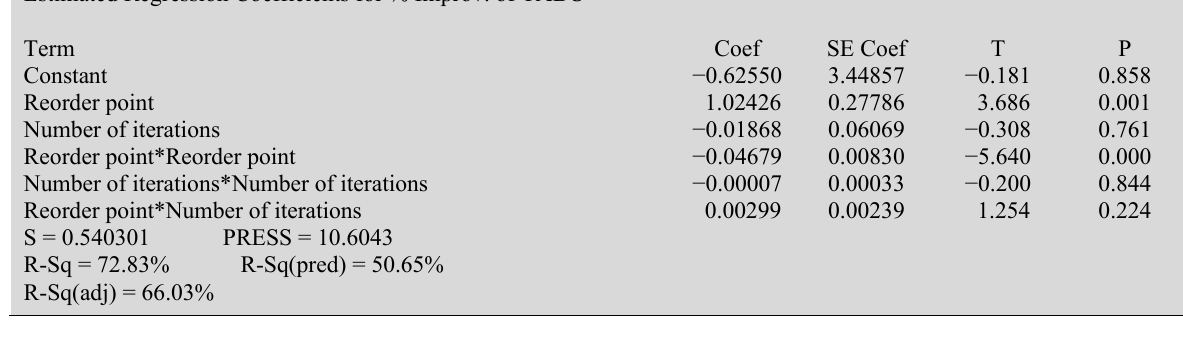
Results of an analysis of variance (ANOVA) for the parameters setting of the tabu search approach Estimated Regression Coefficients for % Improv. of TABU